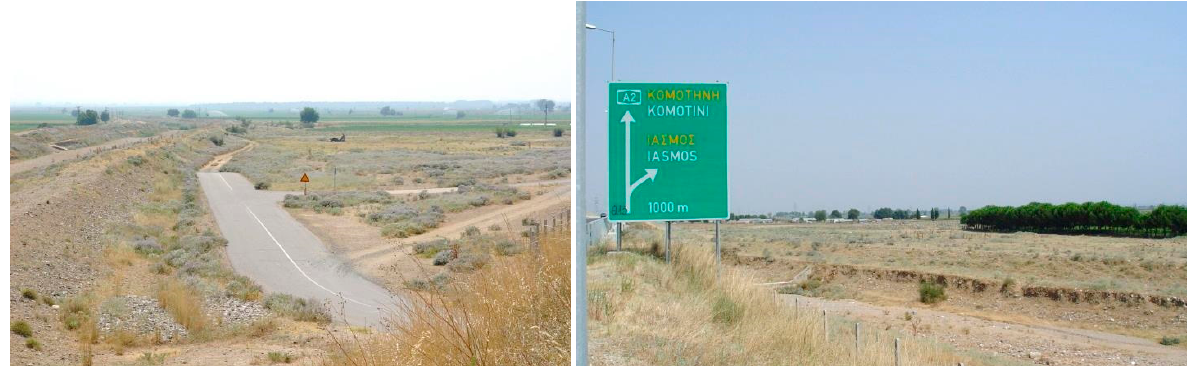
Figure 8. Rural roadsides next to multilane highways invaded by Solanum elaeagnifolium in the Iasmos area (northeastern Greece) during summer.